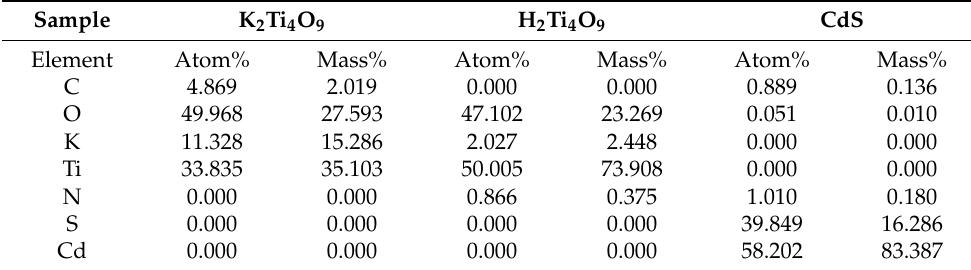
Table 1. EDX analysis of as-prepared K 2 Ti 4 O 9 , H 2 Ti 4 O 9 , and CdS samples.